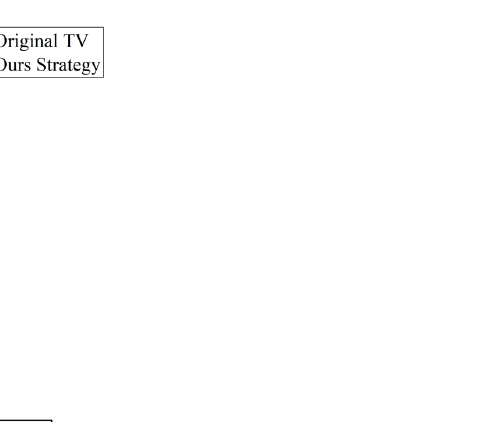
Figure 7. The principle of the proposed image capturing pipeline by using digital capturing devices.